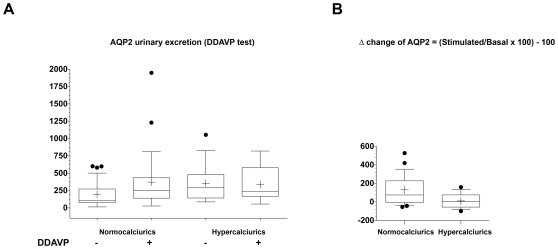
AQP2 excretion during urinary concentration test.For the urinary concentration test, urinary AQP2 excretion and osmolality were measured on samples obtained hourly after 20 µg intranasal DDAVP administration. AQP2 urinary excretion. (A) In normocalciuric children, DDAVP administration resulted in a significant increase in urinary AQP2 excretion. Hypercalciuric children had a high basal AQP2 excretion and DDAVP administration did not result in a significant increase in urinary AQP2 excretion. Data were analyzed by Wilcoxon Signed Rank ANOVA test for paired non parametric data (*p = 0.0023). (B) Comparison of basal AQP2 excretion in hypercalciurics and normocalciurics. patients. In hypercalciurics a significant higher AQP2 excretion was observed (p = 0.036 ANOVA test).